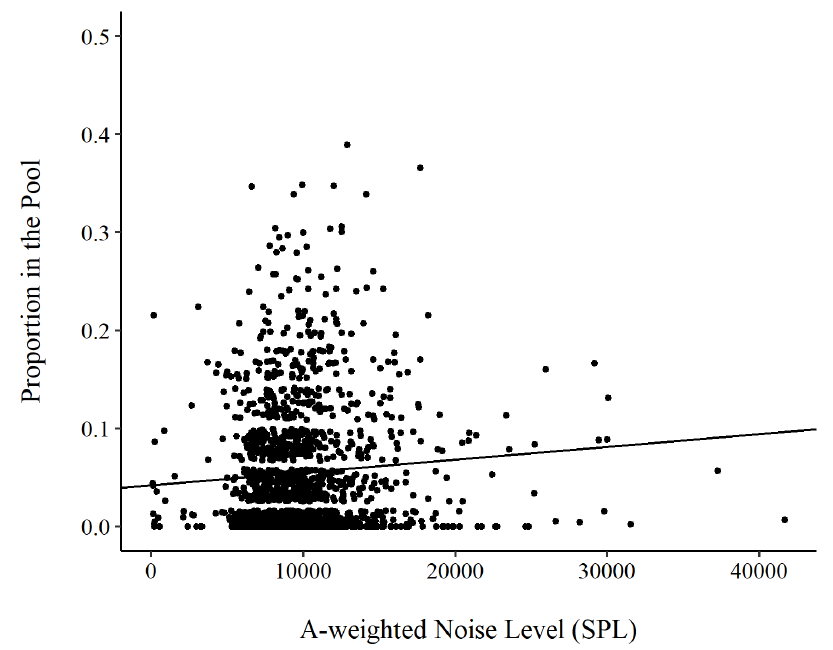
Figure 3 Effects of Average Noise Levels in dBA on Pool Use by Southern Rockhopper